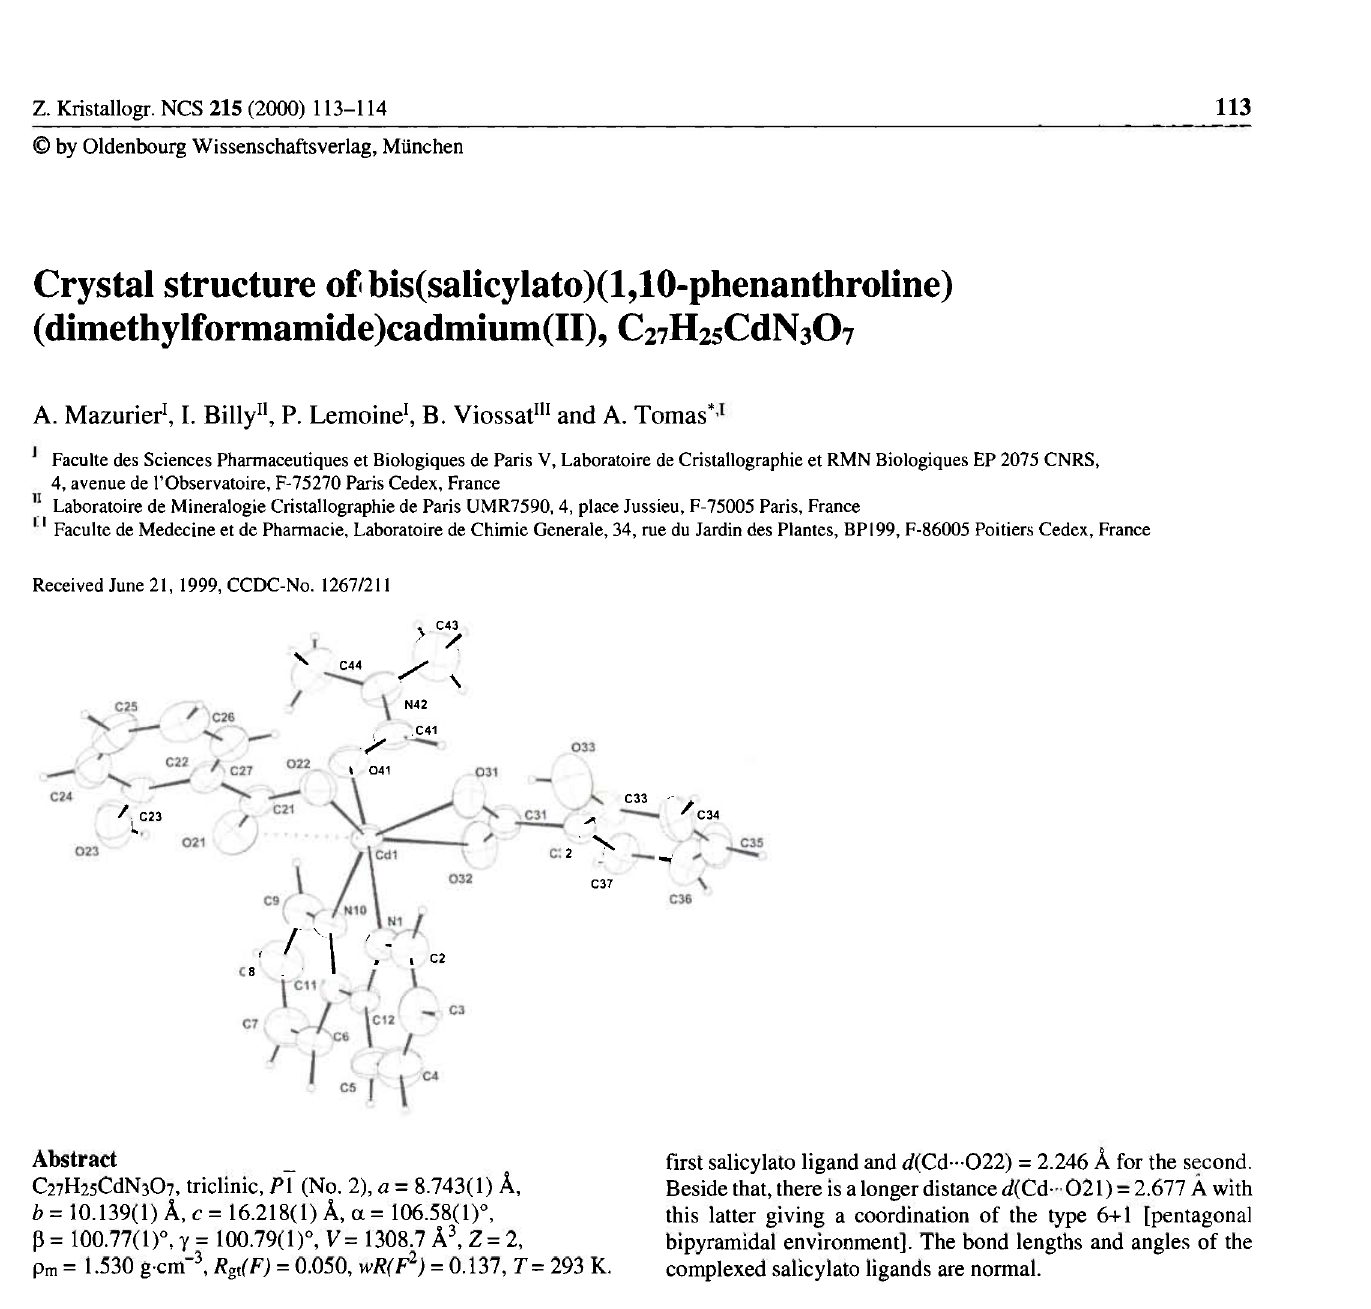
Table 1. Data collection and handling.